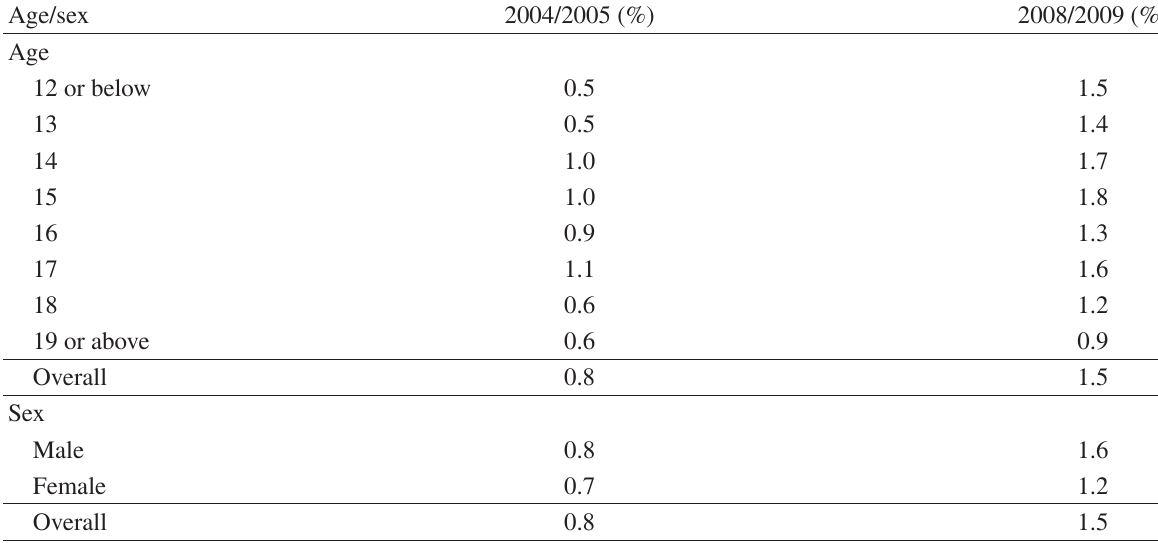
TABLE 4: Proportion of 30-day drug-taking students by age and by sex (Secondary Students) based on 2008/09 survey of drug use among